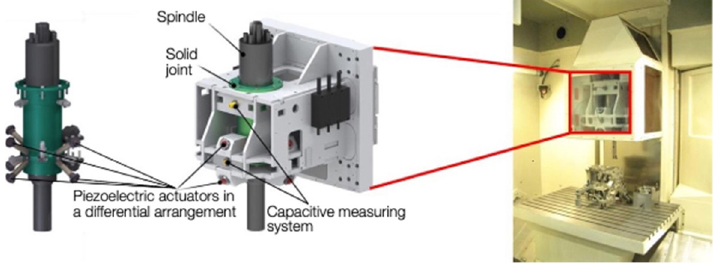
Figure 1. Construction of the piezoelectric kinematic system for non-circular drilling [1].